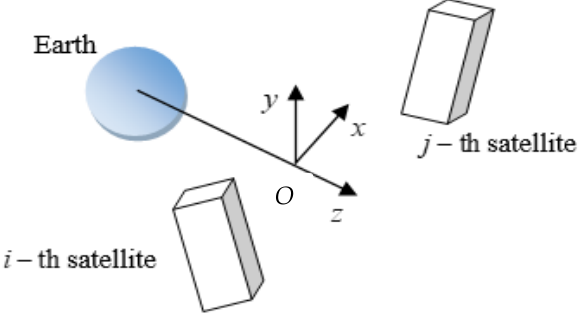
Figure 1. LVLH reference frame.